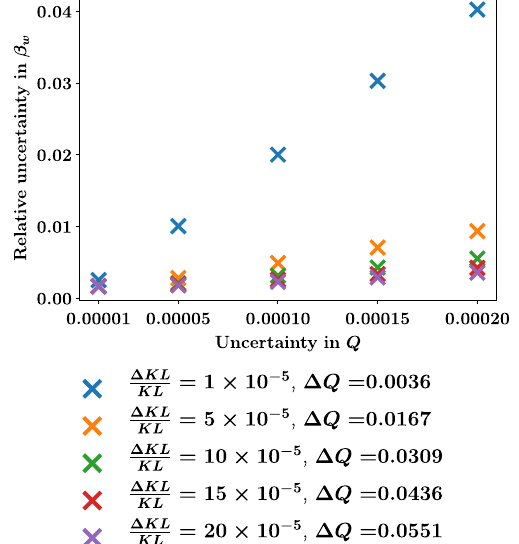
FIG. 9. Uncertainty in the β w measurement in LER for different uncertainties in the tune measurement, as well as for different values of modulation strength Δ KL . Simulated for nominal β (cid:1) y ¼ 270 μ m.